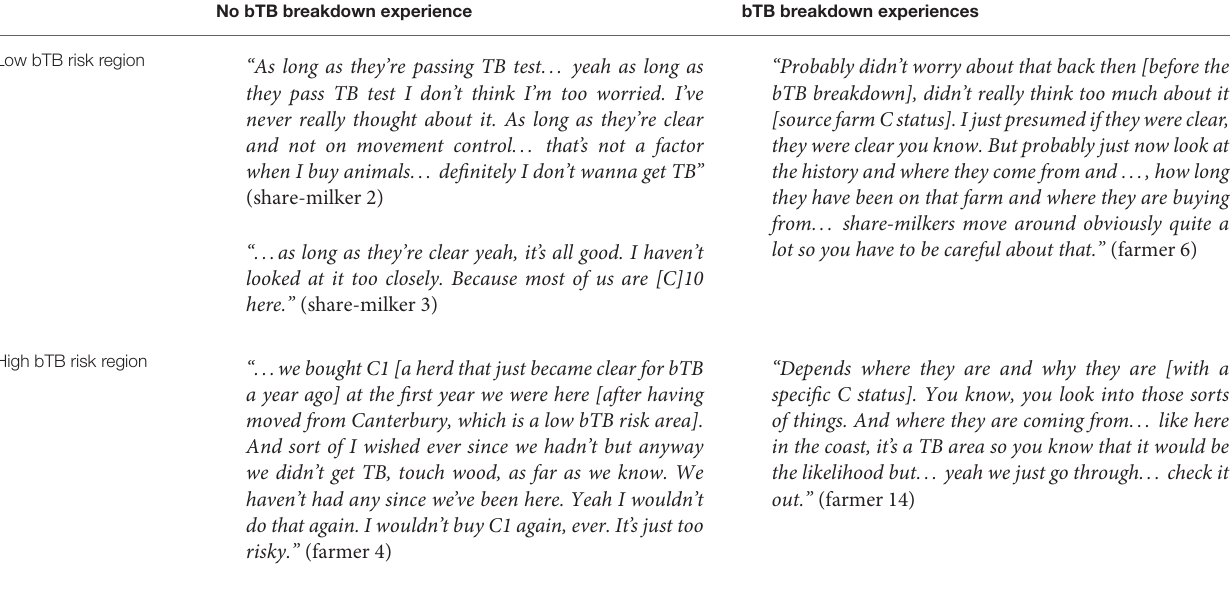
TABLE 3 | A summary of quotes on the C status from farmers stratified by the risk of bTB in their farming regions and the presence of a bTB breakdown